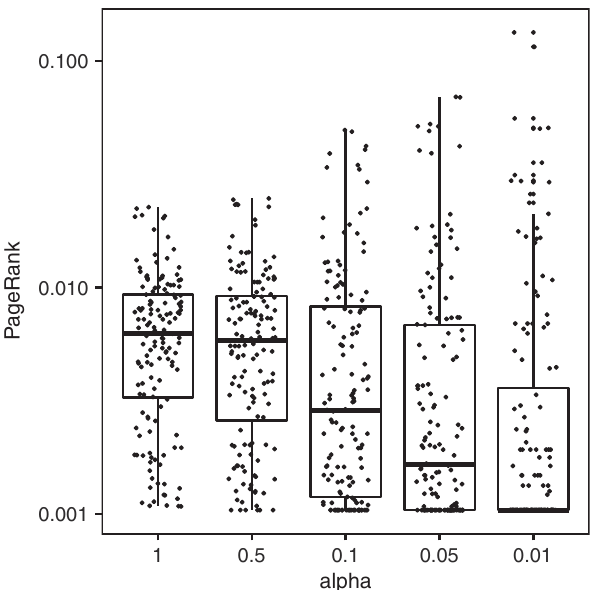
FIG. 5. Box plots of PageRank centrality for the semester 1 network backbones. The bottom, middle, and top line of the boxes show first quartile, median, and third quartile. The upper and lower “ whiskers ” extend to the maximum and minimum values or 1.5 times the interquartile range, whichever is larger. As alpha decreases, more node centralities cluster at the minimum